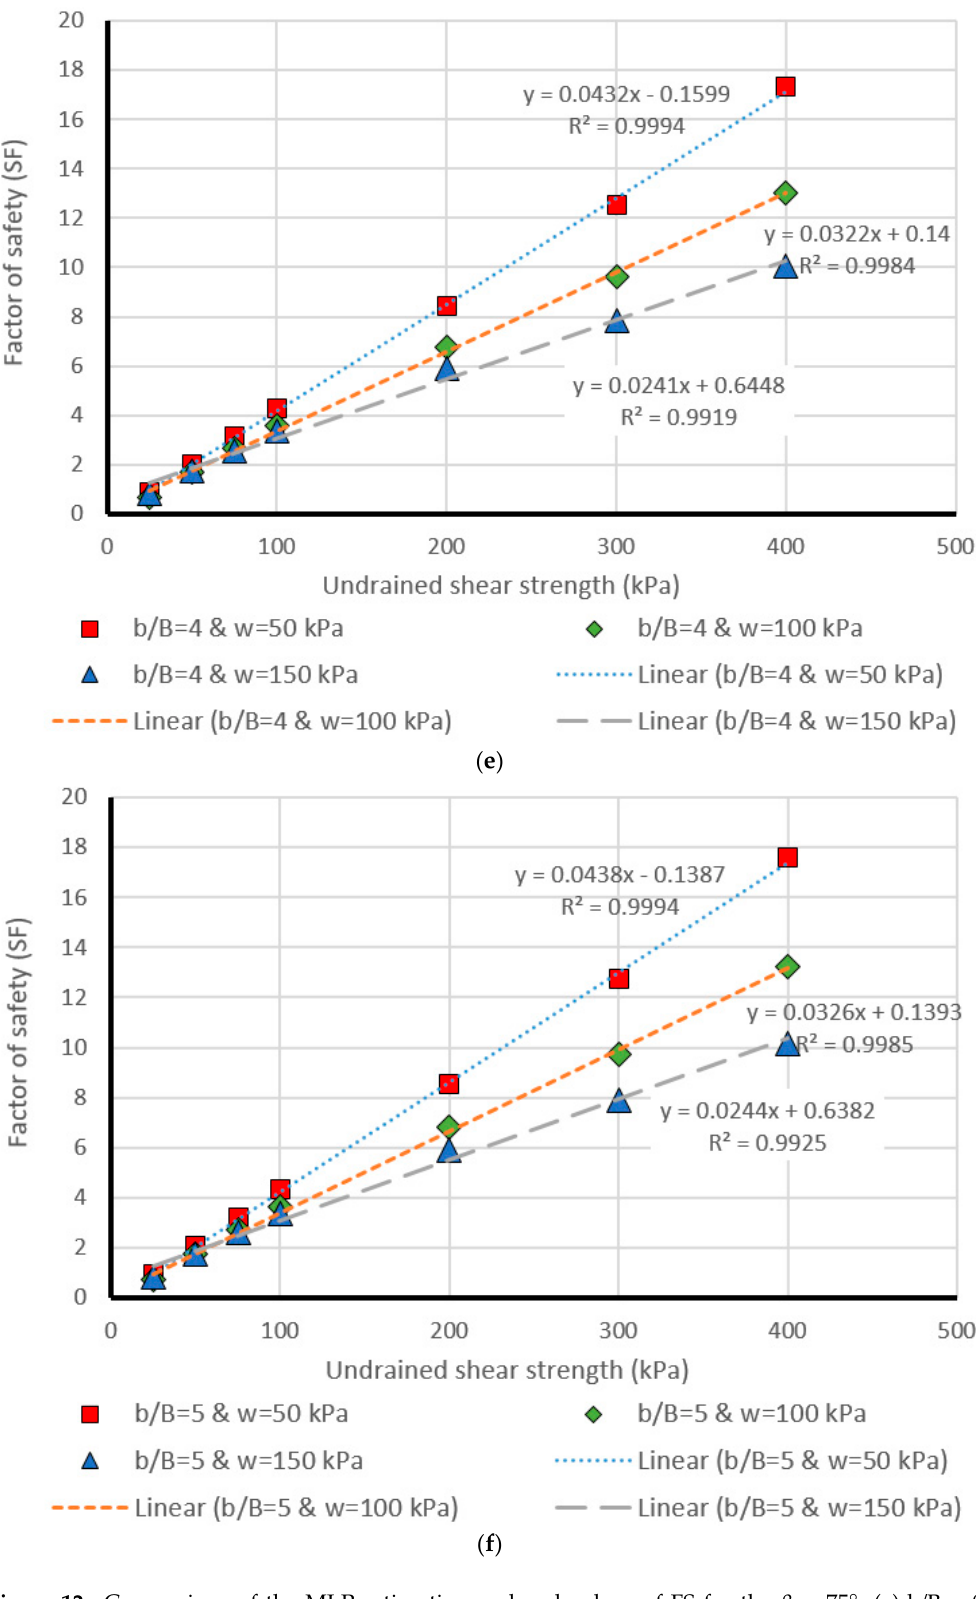
Figure 12. Comparison of the MLP estimation and real values of FS for the β = 75°, ( a ) b/B =